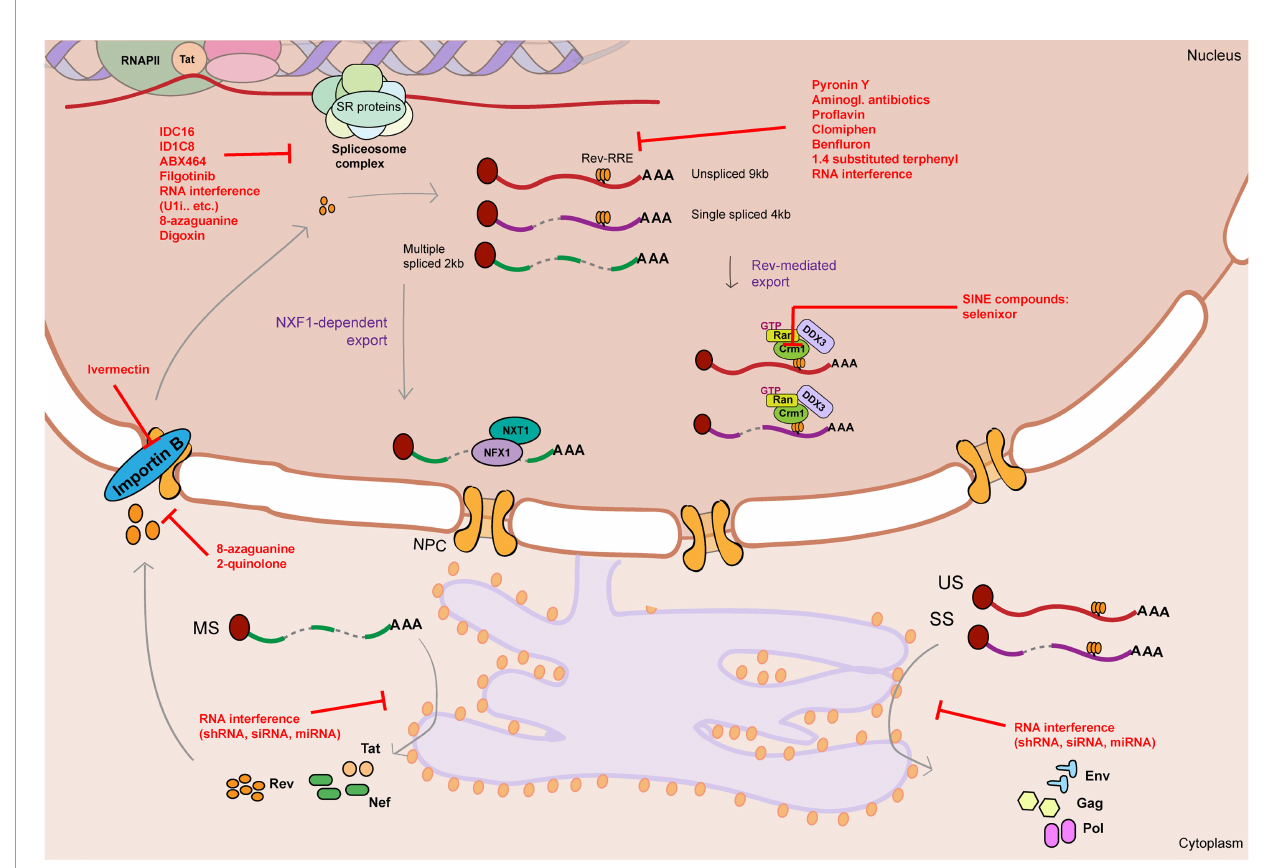
FIGURE 3 | Graphical summary of therapeutics that target HIV-1 RNA metabolism. HIV-1 RNA metabolism can be therapeutically targeted by drugs/therapeutics that interfere with splicing (IDC16, ID1C8, ABX464, Filgotinib, RNA interference therapeutics, 8-azaguanine, Digoxin), Rev-RRE binding (Pyronin Y, Aminoglycosid antibiotics, pro fl avine, Clomiphen, Ben fl uron, 1.4 substituted terphenyl, RNA interference therapeutics), Rev-mediated export (CRM1 inhibitors: SINE compounds), Rev nuclear import (Ivermectin, 8-azaguanine, 2-quinolone) and translation of viral RNA (RNA interference therapeutics). Unspliced 9kb viral RNA is represented as a red curved line. Single spliced 4kb viral RNA is represented as a partially cut purple curved line. Multiple spliced 2kb viral RNA is represented as a partially cut green curved line. Red fl at-head arrows represent therapeutic targets. RRE stands for Rev response element. NPC stands for nuclear pore